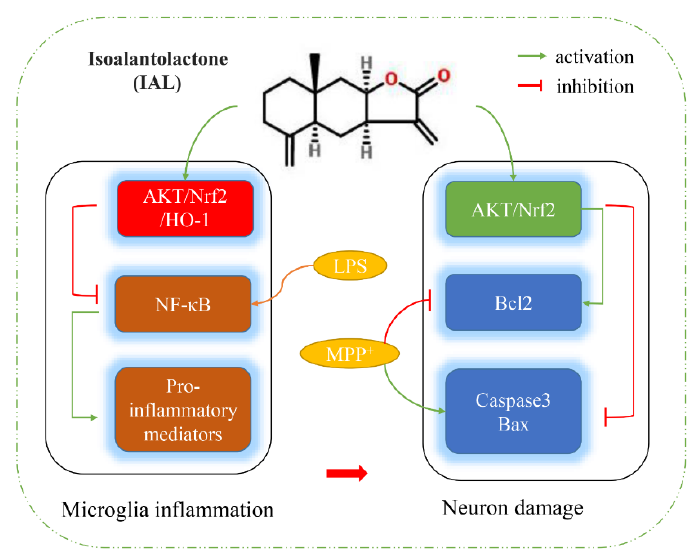
Figure 9. Flowchart of how IAL works. IAL regulates neuro-inflammation and neuronal apoptosis to ameliorate PD symptoms.